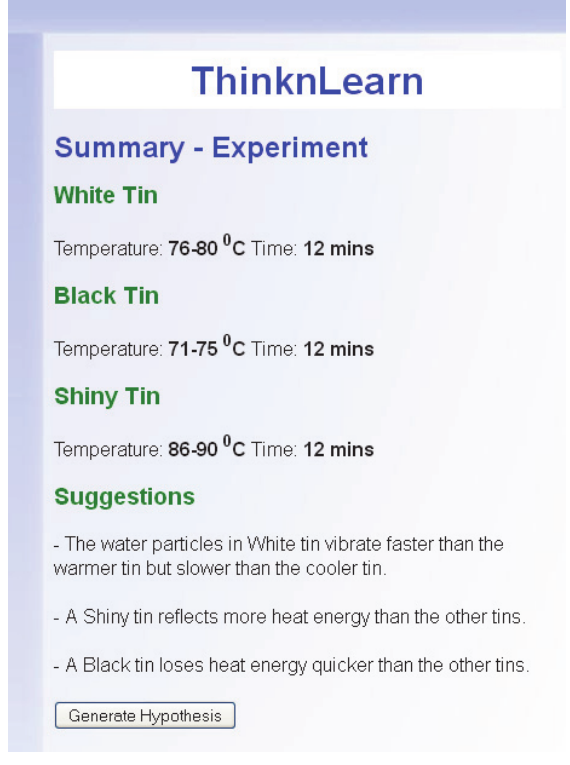
Figure 12 . Experimental Summary.